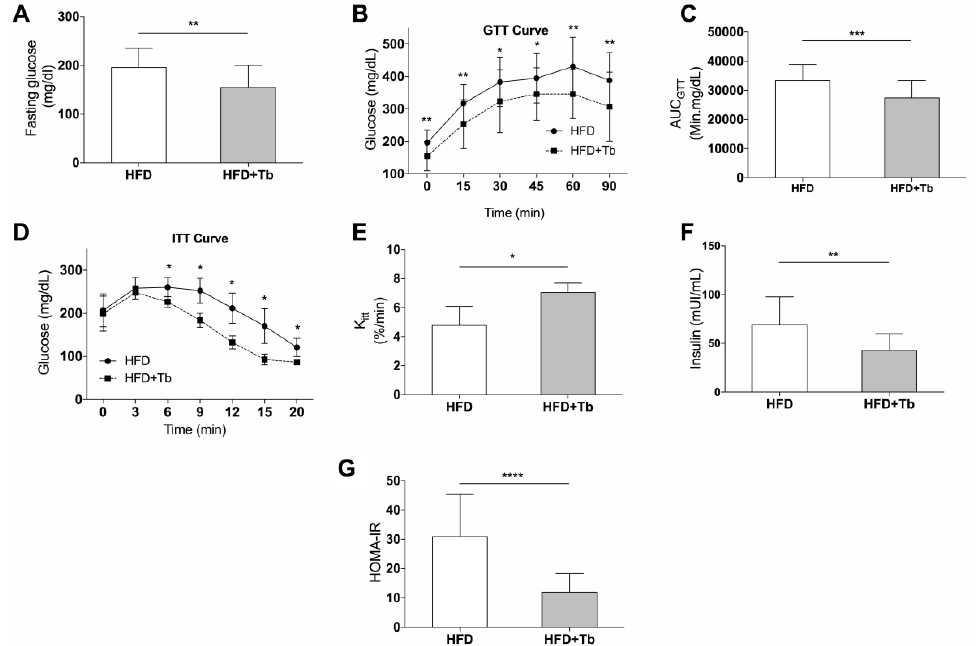
Figure 2. Tb administration improved glucose homeostasis in obese mice. ( A ) Glucose quantification in samples from 6 h fasted mice ( n = 24–27 mice per group). ( B ) Glucose Tolerance Test was performed at the 12th week of the protocol ( n = 23–27 mice per group). ( C ) Incremental area of blood glucose in the GTT ( n = 23–27 mice per group). ( D ) Insulin Tolerance Test (ITT) was performed at the 13th week of the protocol ( n = 4,5 mice per group). ( E ) Rate of blood glucose disappearance (KITT) was calculated using data from ITT ( n = 4 mice per group). ( F ) Serum insulin measured at the end of the protocol ( n = 12–18 mice per group). ( G ) HOMA-IR was calculated from fasting insulin and fasting glucose ( n = 12–18 mice per group). Data are presented as mean ± SD. **** p < 0.0001, *** p < 0.001, ** p < 0.01, * p < 0.05 HFD vs. HFD + Tb, Student’s t -test (A–F) or Mann–Whitney (D and G). Cells 2020 , 9 , x FOR PEER REVIEW